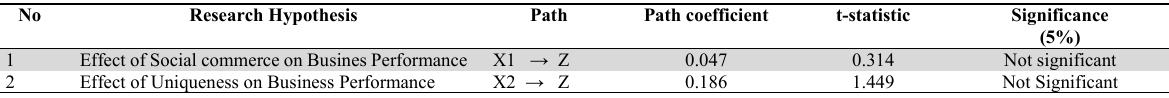
Effect of Social Commerce and the Uniqueness of Resource Capability on Business Performance of MSMEs in Jambi Prov- ince